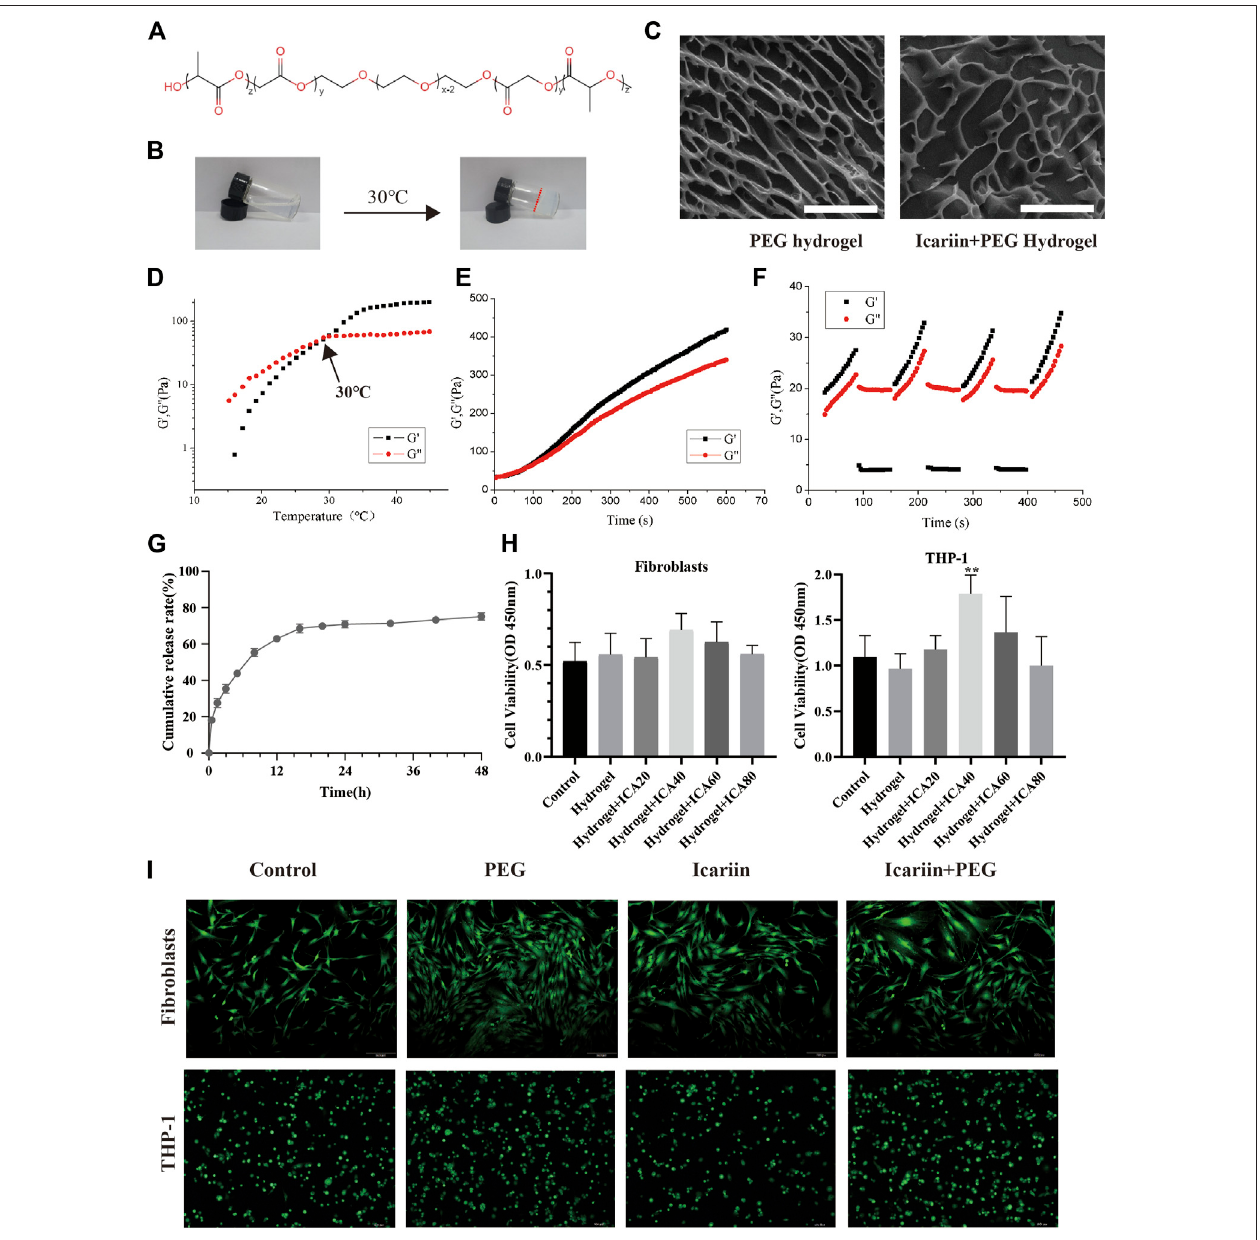
FIGURE 1 | Characterization and biocompatibility of the PEG hydrogel. (A) Chemical structure of the PEG hydrogel. (B) PEG hydrogel solution gelled at 30 ° C. (C) Cryo-scanning electron microscopy images of PEG and icariin+PEG hydrogels. Scale bar, 30 μ m. (D) Temperature dependence of the storage modulus (G ′ ) and loss modulus(G ″ )ofthePEGhydrogel. (E) GelationtimeofthePEGhydrogelat35 ° C. (F) G ′ andG ″ ofthePEGhydrogelwhencirculated threetimesbetweenstrainof1and 1,000%. (G) Release pro fi le oficariin from the icariin+PEG hydrogel by UV spectrophotometry. (H) Cell viability on human fi broblastcells and THP-1 macrophages with hydrogel extracts of different compositions for 48 h. ICA20: 20 μ g/ml icariin, ICA40: 40 μ g/ml icariin, ICA60: 60 μ g/ml icariin, ICA80: 80 μ g/ml icariin, ** p < 0.01 vs . the control. (I) Fluorescence microscopy of fi broblasts and macrophages was performed with live/dead cell staining. Live cells emit green fl uorescence, while dead cells emit red fl